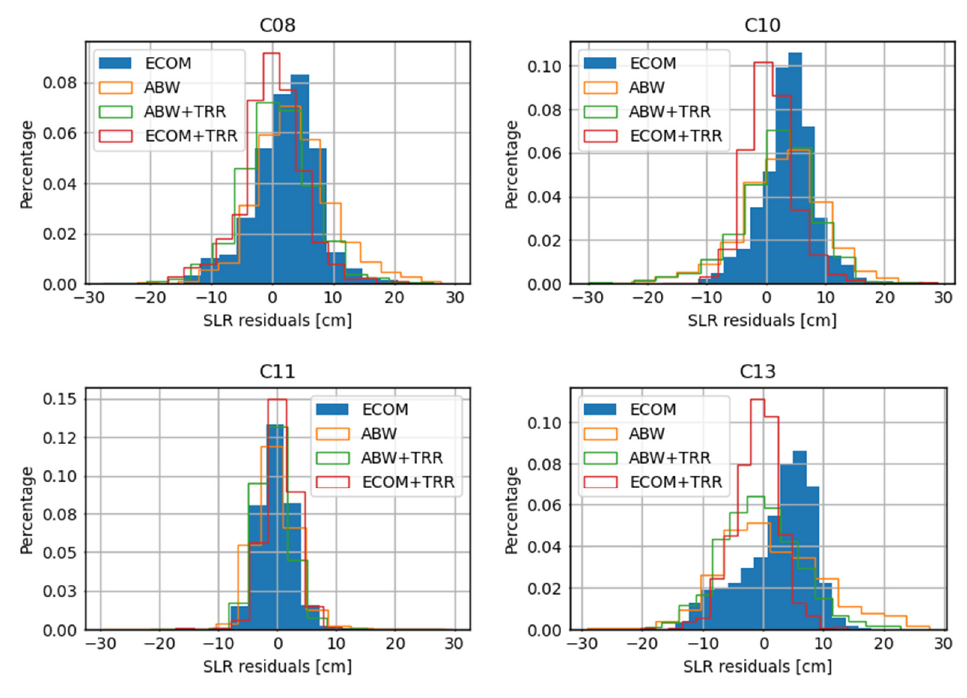
Figure 10. The histograms of the SLR residuals of the four solutions for the four BDS-2 IGSO and MEO satellites tracked by ILRS. All values are in cm. Table 5. The SLR residual statistics for the four orbit solutions of C08, C10, C11, and C13. (unit: